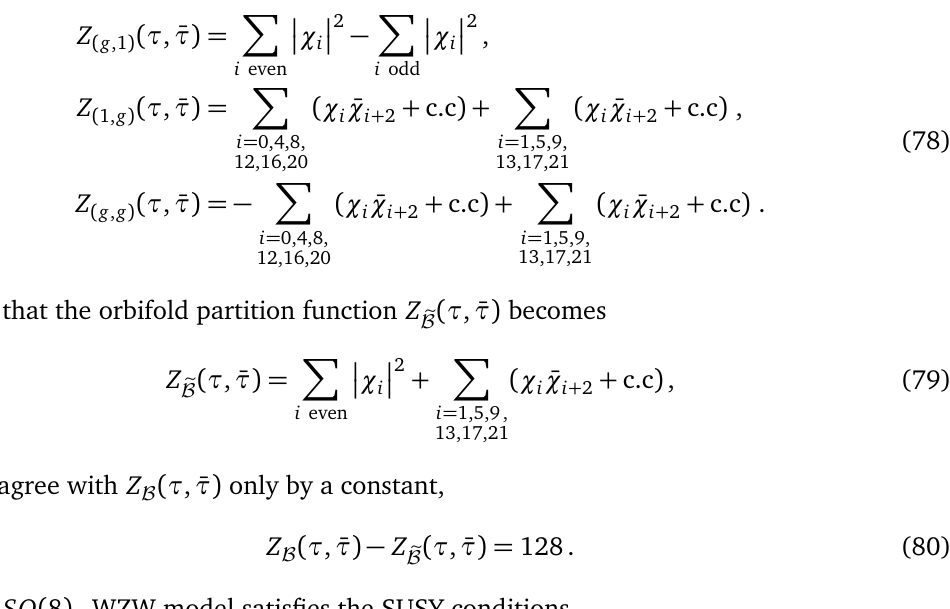
: primaries labeled by i are characterized by weights h and SO ( 8 ) Dynkin labels. 3